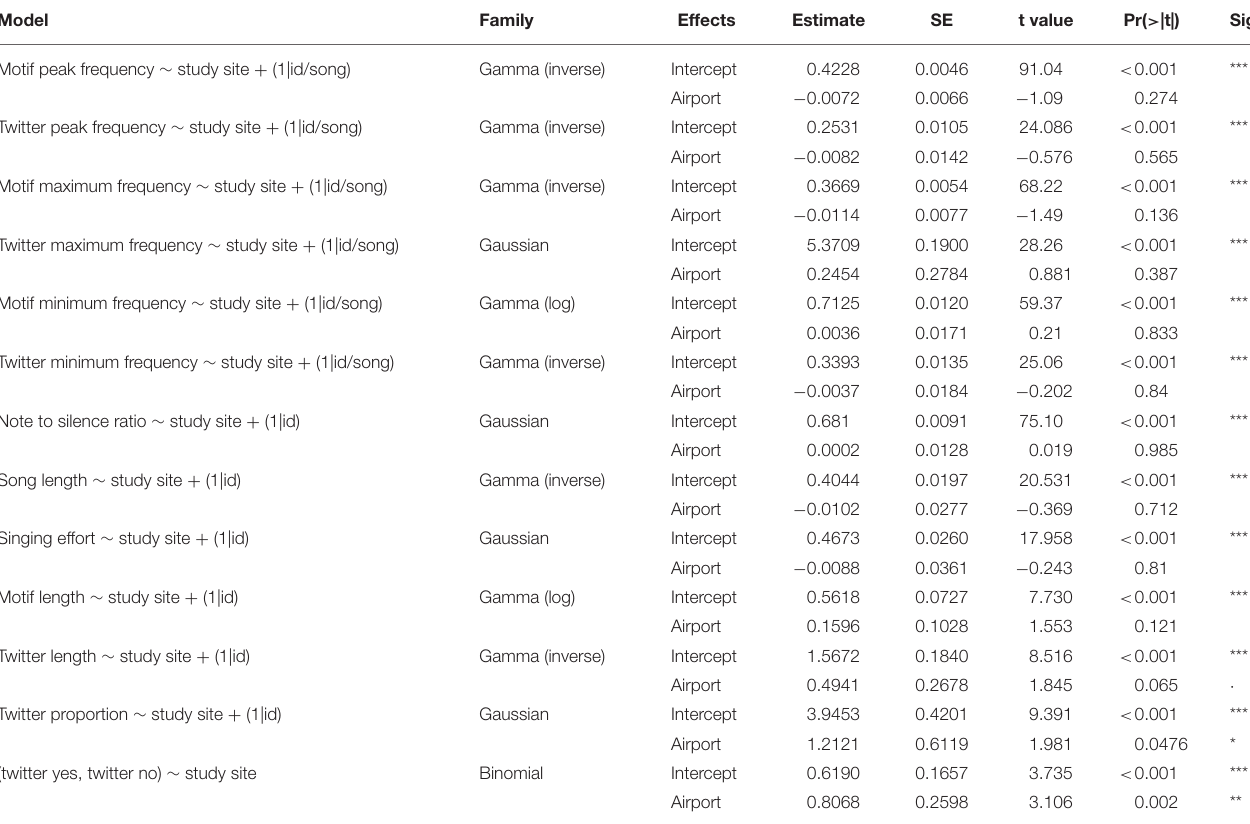
TABLE 2 | Results of GLMMs modeling song characteristics.